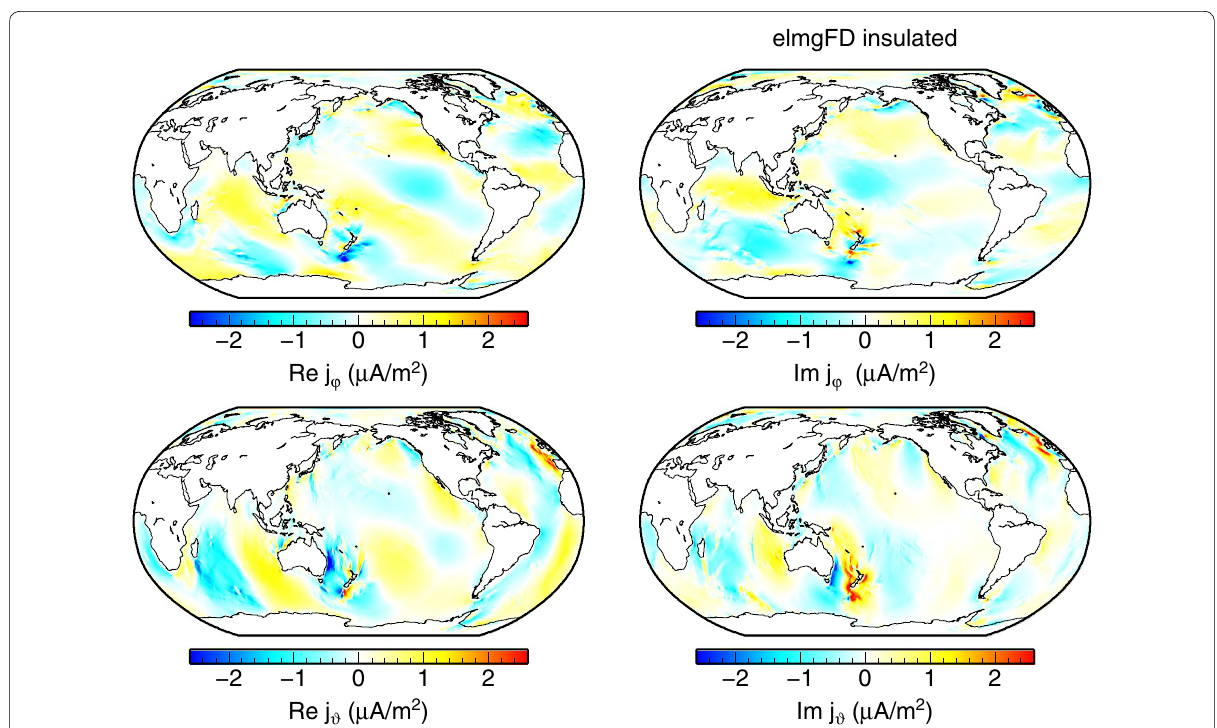
Fig. 13 Electric current density at the seafloor. The horizontal components obtained for the insulated solution. The radial component is zero everywhere in this